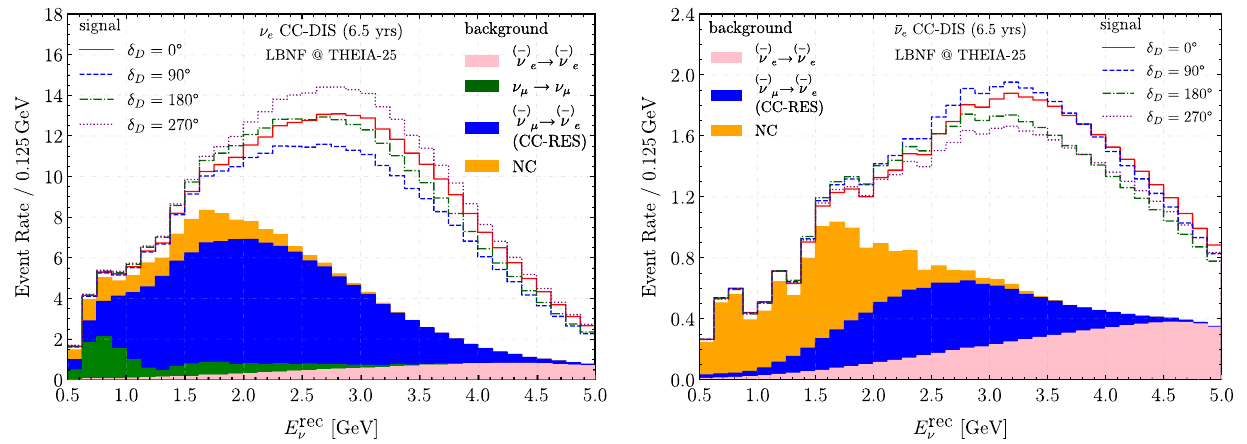
Fig. 11 The event spectra of CC-DIS signal and its background at the THEIA-25 detector with LBNF neutrino (left) and anti-neutrino (right) beams. Four solid lines are used for δ D = 0 ◦ (red), 90 ◦ (blue), 180 ◦ (green), and 270 ◦ (purple). For comparison, the filled regions stand